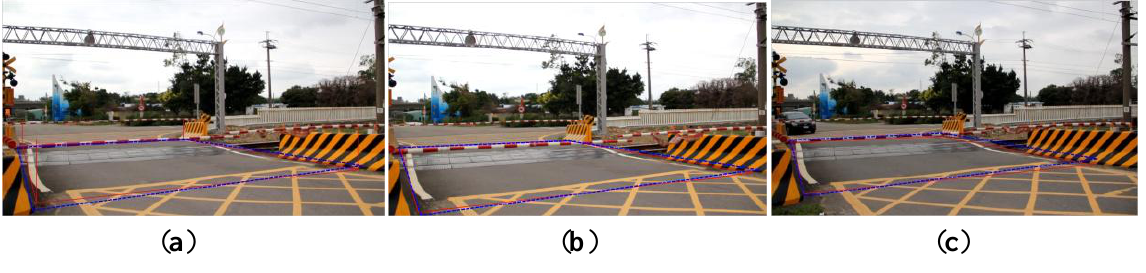
Figure 17. The detection result of the risk area corresponding to case-3, NanPin Road; the blue-line area is the detection result, and the red-line area is the real measured result: ( a ) the measurement result with the camera mounted in the standard position; ( b ) the measurement result with the camera moved forward 50 cm; ( c ) the measurement result with the camera moved backwards 50 cm.